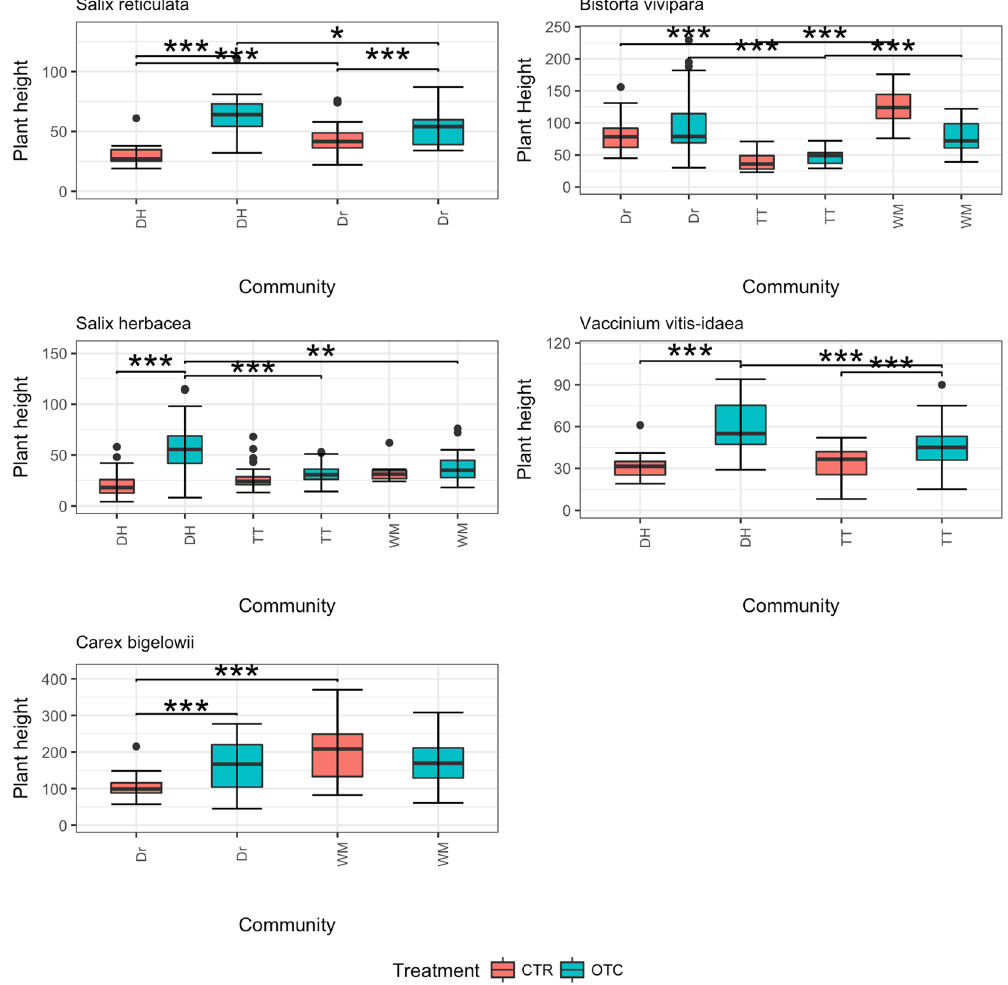
Figure 5. Community-specific response of different plant species to warming in terms of plant height (in mm). The five species shown ( Bistorta vivipara, Salix herbacea, Salix reticulata, Vaccinium vitis-idaea , Carex bigelowii ) responded to 23 years of warming in at least two communities (Dr = Dryas heath, TT = tussock tundra, WM = wet meadow, DH = dry